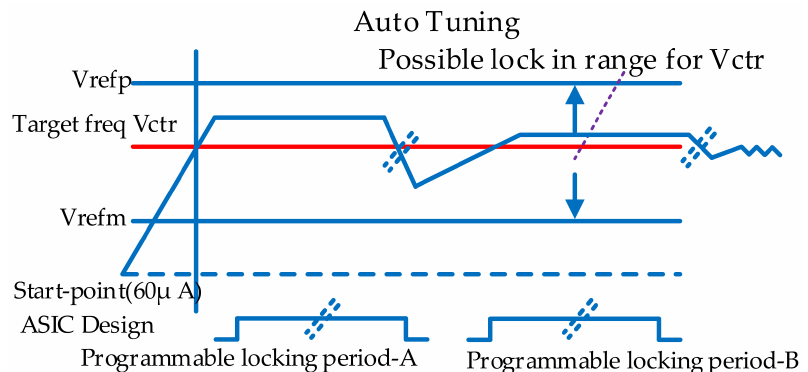
Figure 4. Lock-in range for Vctr with the minimum and maximum Vref